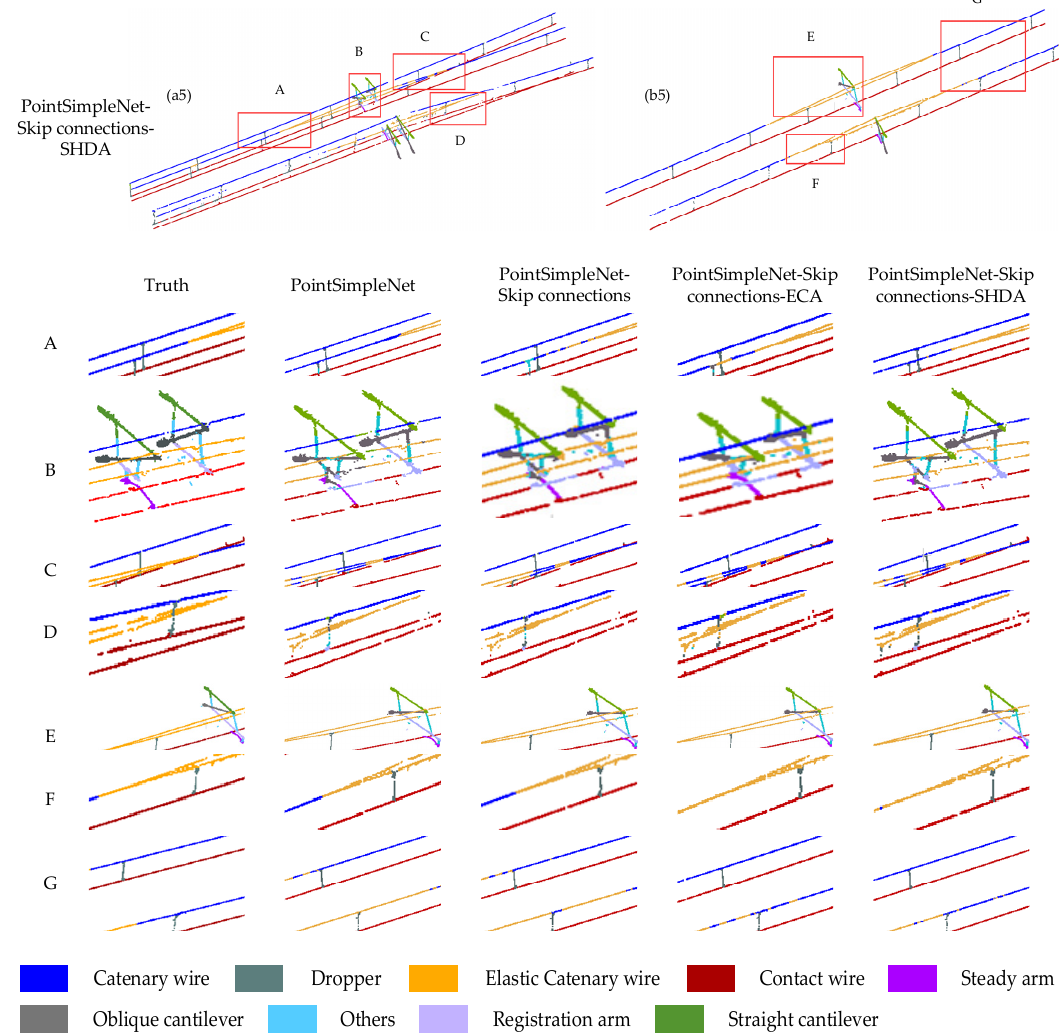
Figure 11. Comparison results between different connection methods added to the basic frame. Columns ( a1 – a5 ) and column ( b1 – b5 ) are global maps of the double-arm scene and the single-arm scene, respectively. The range delineated in the red box is enlarged to present a more detailed visual comparison at the bottom, where A, B, C, and D are the ROI in the double-arm scene, and E, F, and G are the ROI in the single-arm scene.